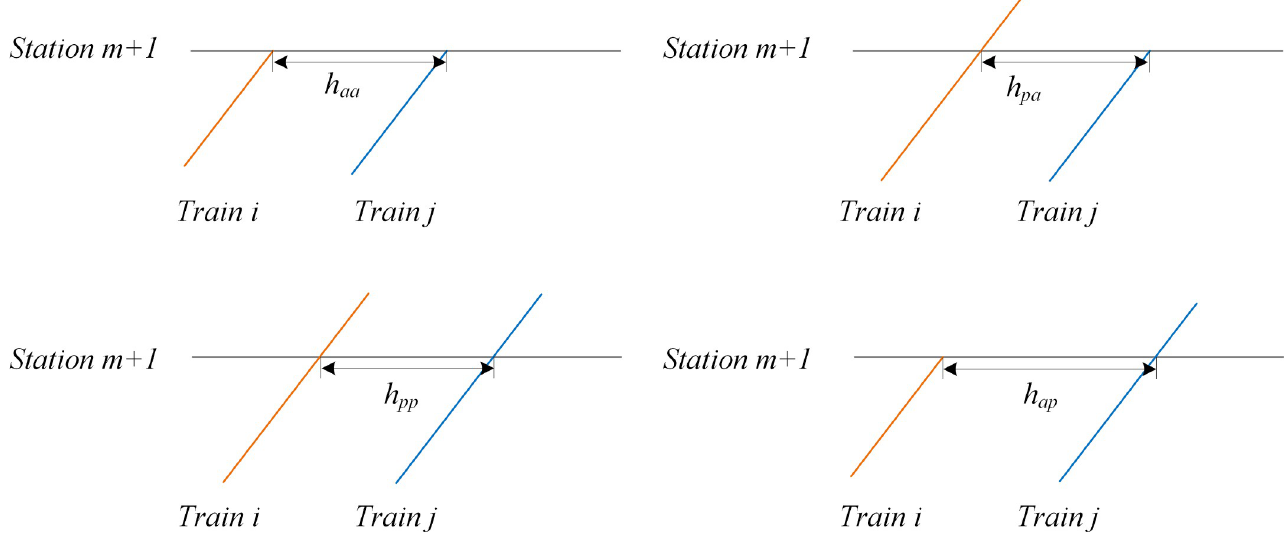
Fig 5. Arrival headway in different situation of train